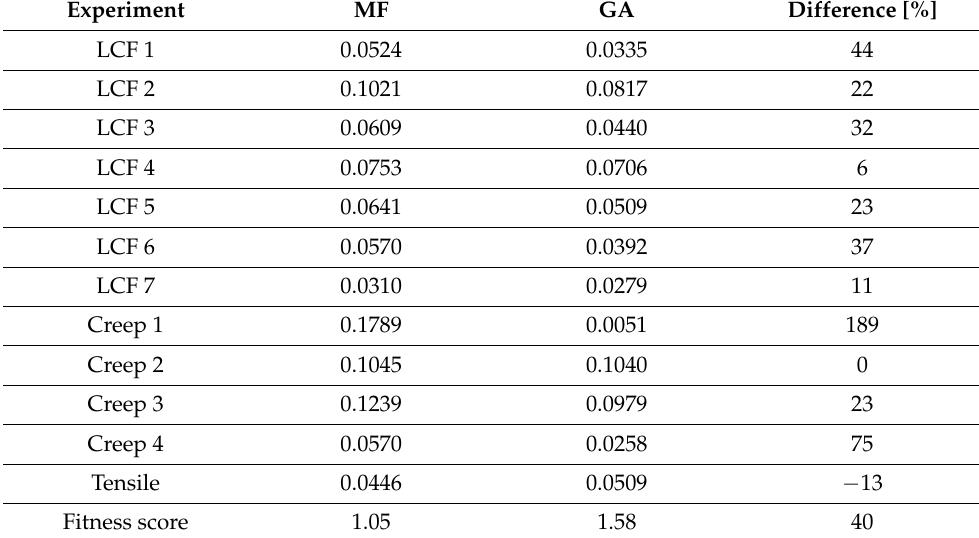
Table 3. SM for parameters from the MF method and for the optimum found by GA are gathered in this table. In the last row, the calculated fitness score (Equation (6)) is presented. The difference is calculated by Equation (7) and is positive when it shows improvement of the